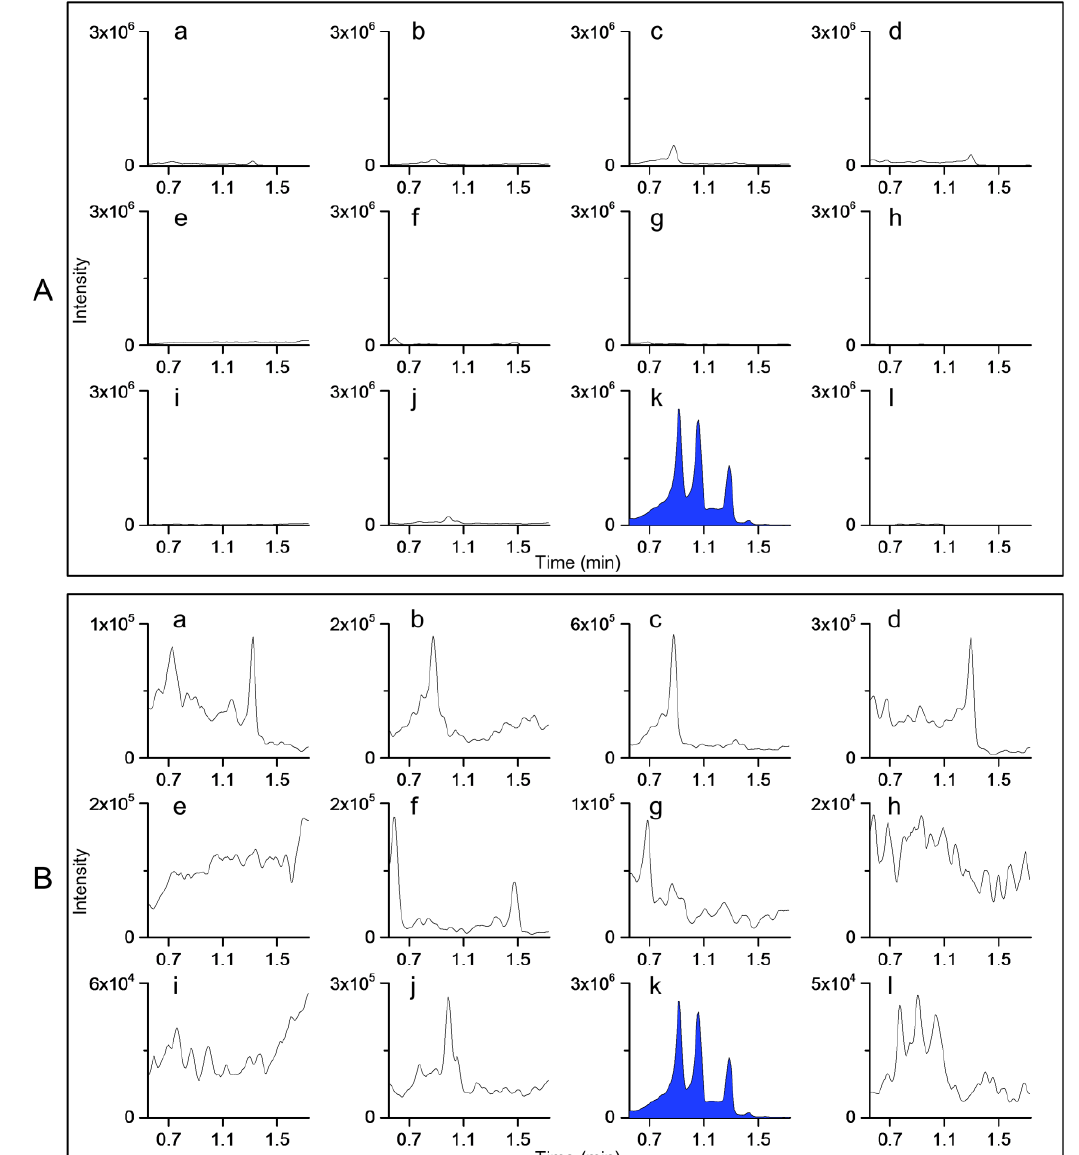
Figure 5. Fingerprints of all studied species with the species-specific method I for Syringa vulgaris . ( A ) The y-axes of all samples were scaled according to the most intensive peak of all samples, which was produced by S. vulgaris . ( B ) The y-axes were scaled to the most intensive peak of each sample. Plant species are as follows: ( a ) Acer platanoides , ( b ) Alnus glutinosa , ( c ) Alnus incana , ( d ) Fraxinus excelsior , ( e ) Populus tremula , ( f ) Prunus padus , ( g ) Quercus robur , ( h ) Salix phylicifolia , ( i ) Sorbus aucuparia , ( j ) Sorbus hybrida , ( k ) Syringa vulgaris , and ( l ) Tilia cordata . Tilia × europaea produced a similar fingerprint to that of Tilia cordata